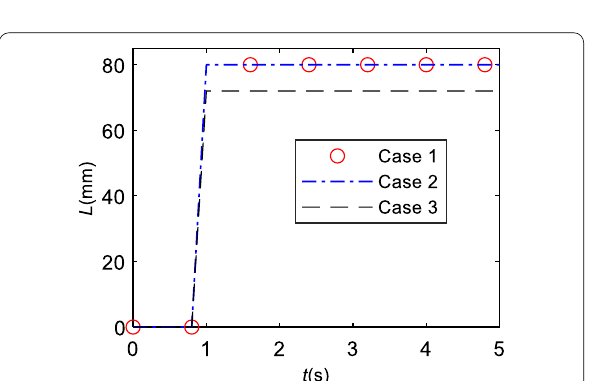
Figure 9 Displacement of the hydraulic cylinder before and after